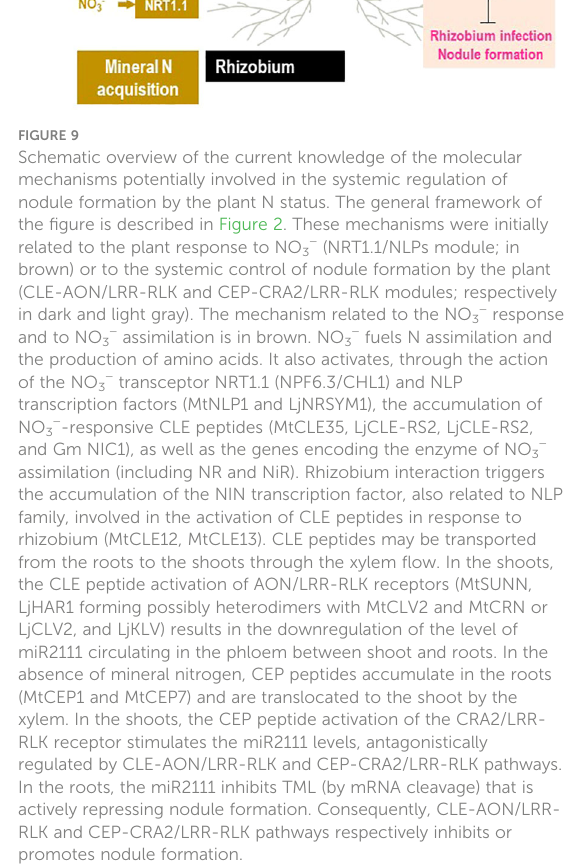
et al., 2014; Huault et al., 2014). Their capacity to form nodules with rhizobium is dramatically impaired due to the absence of a systemic signaling originated from the shoot (Huault et al., 2014; Laffont et al., 2019). The MtCRA2 gene, impaired in the mutants, encodes a Leucine-